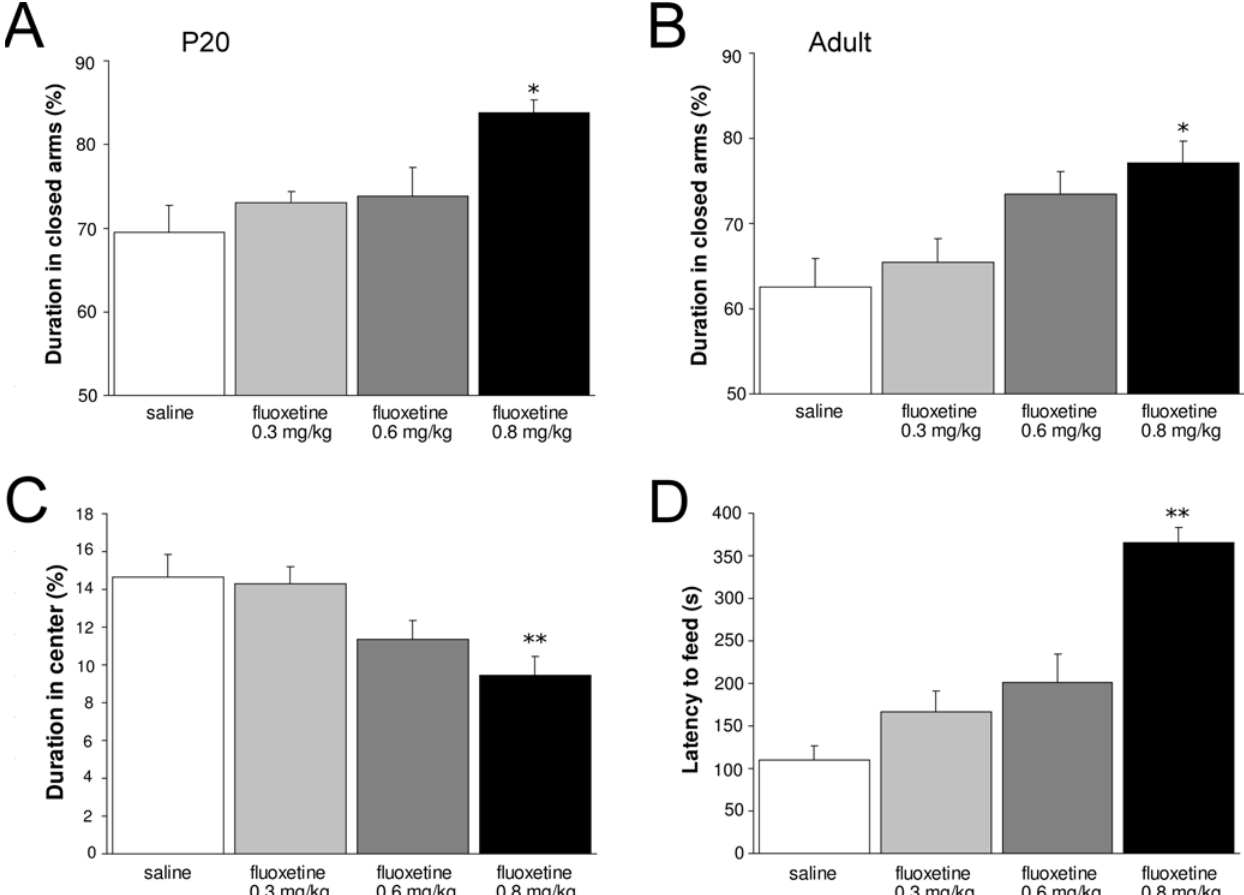
Figure 7. Behavioral data of the elevated plus maze (A, B), open field (C) and the novelty suppressed feeding test (D) presented as mean 6 S.E.M. for groups treated with saline (white bars), 0.3 mg/kg/day fluoxetine (light gray bars), 0.6 mg/kg/day fluoxetine (dark gray bars) and 0.8 mg/kg/day fluoxetine (black bars). * p , 0.05; ** p , 0.01.